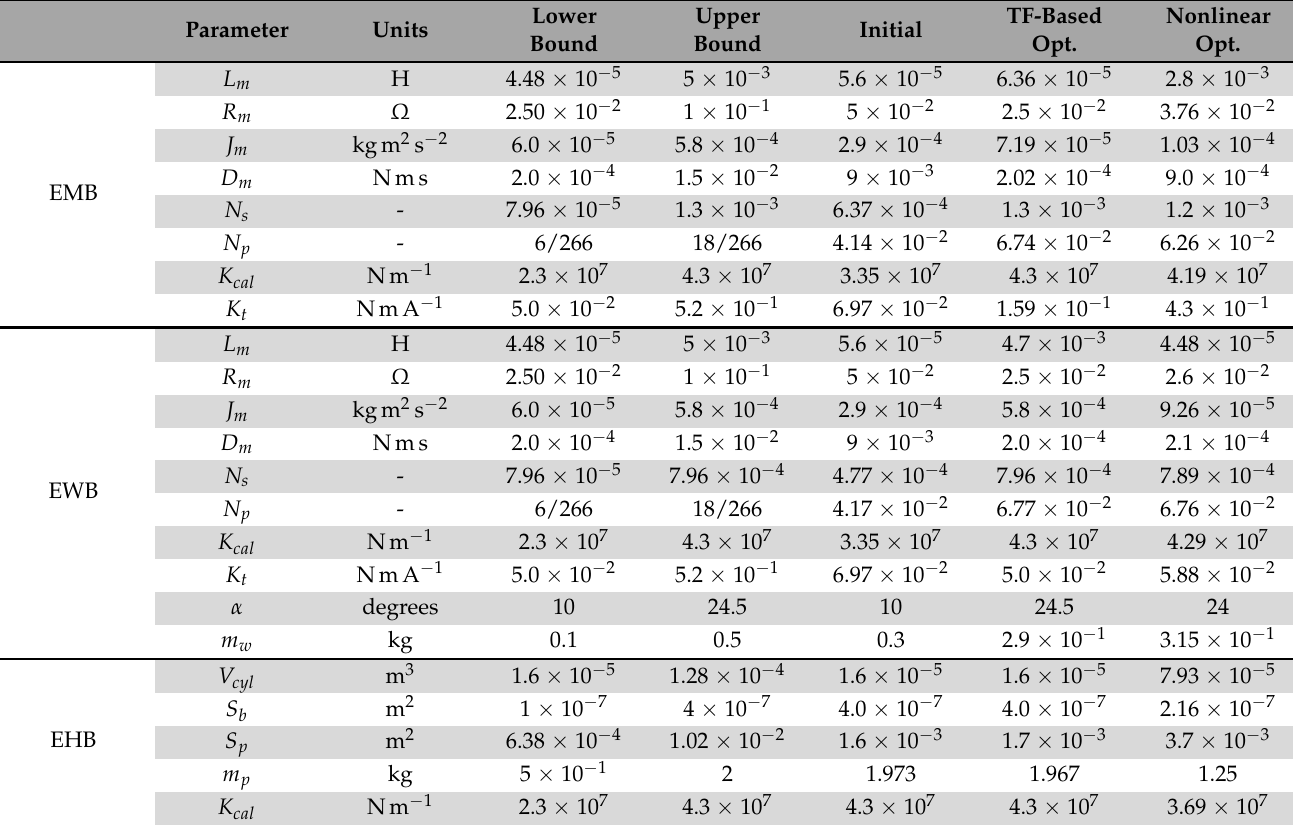
Table 1. Initial and optimized physical parameter values of EMB, EWB, and EHB and the range of the